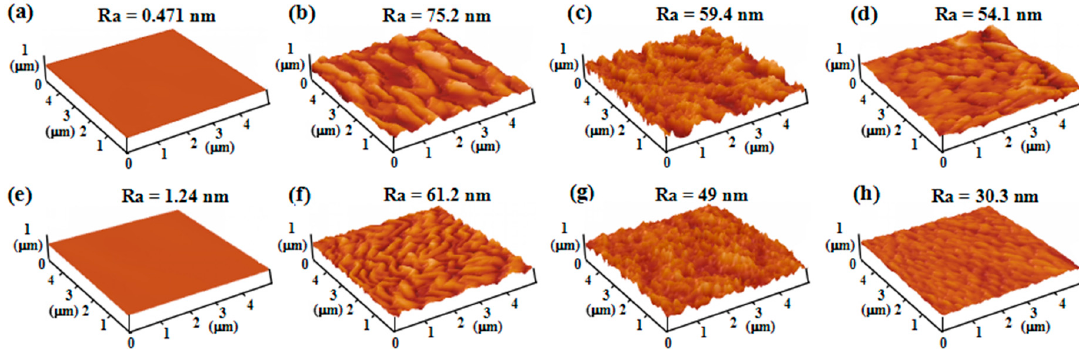
Figure 5. Atomic force miscroscopy ( AFM) images of ( a ) pristine film, ( b ) M 1 -1, ( c ) M 2 -1, ( d ) M 3 -1, ( e ) pristine film after shrinking for 60 s, ( f ) M 1 -3, ( g ) M 2 -3, ( h ) M 3 -3.